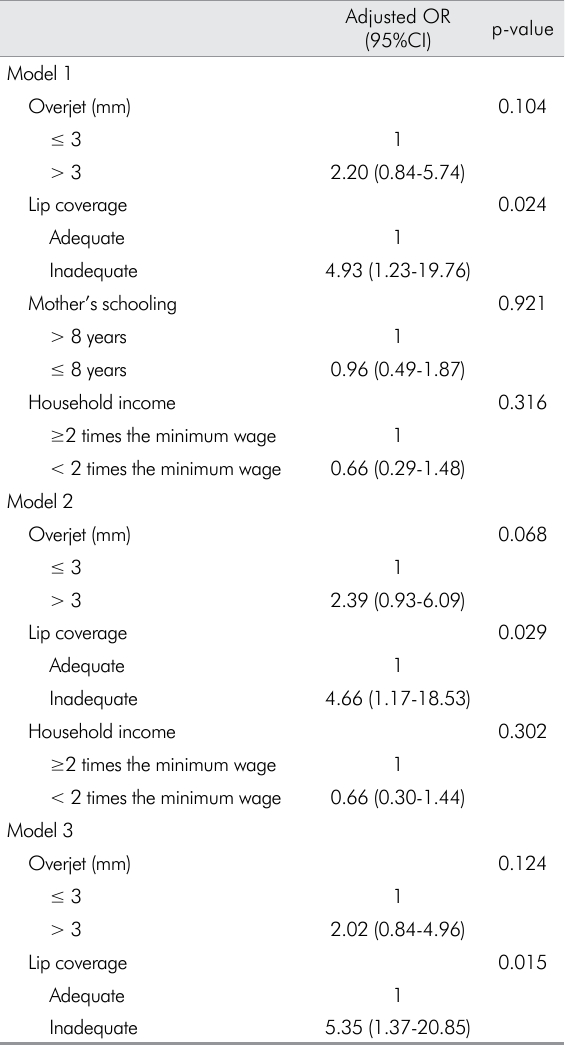
Table 2. Adjusted logistic regression model for independent variables in children with TDI; Diamantina,